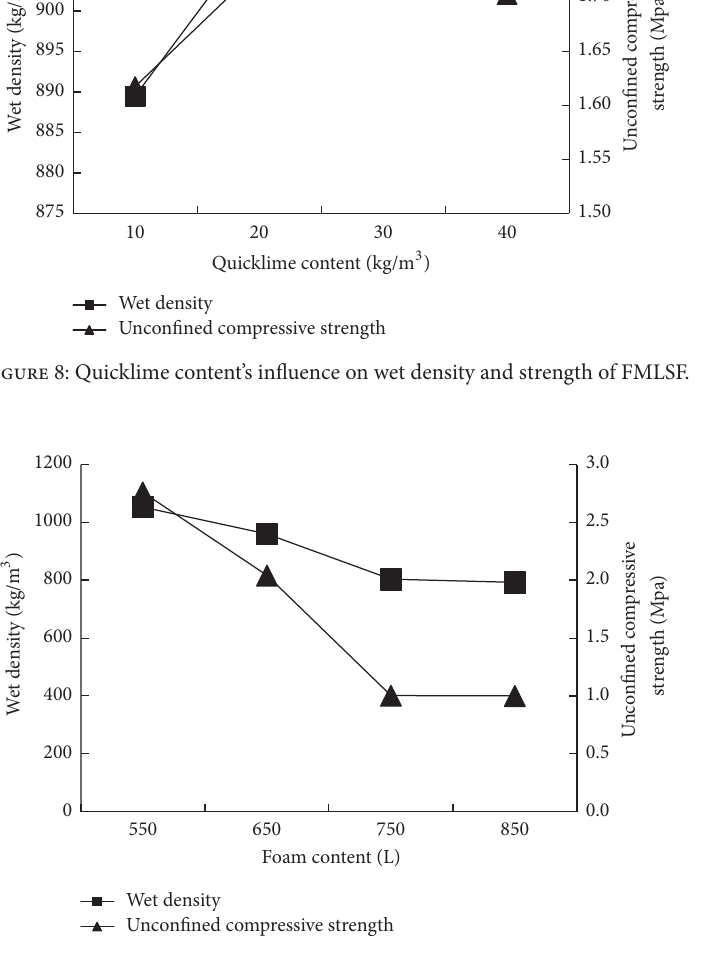
Figure 9: Foam content’s influence on wet density and strength of